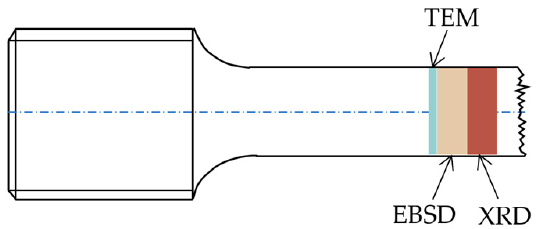
Figure 2. Illustration of sampling location for microstructure observation. The dislocation density was calculated according to the modified Williamson–Hall method using the full width at half maximum (FWHM) of the X-ray diffraction peak. The equipment model was Bruker D8 Advance X with a Cu K α radiation ( λ = 0.15418 nm). The working voltage was 40 kV and the current was 40 mA. The range of the incident angle was 10 ◦ to 90 ◦ at the scanning rate of 1 ◦ /min, while the canning step was 0.02 ◦ . The